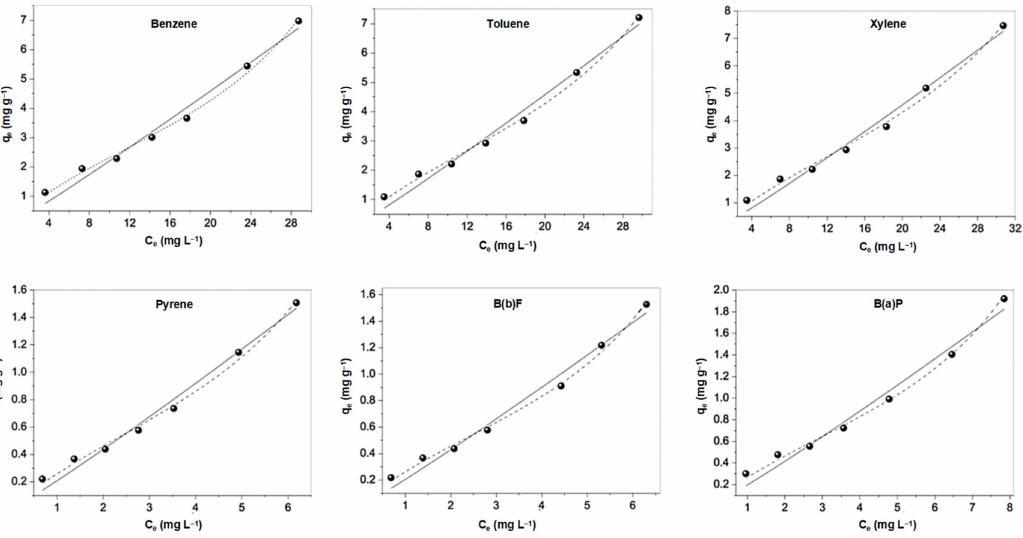
Figure 10. Adsorption isotherms of different aromatic hydrocarbon compounds at 25 ◦ C [58] (The solid line is the fit of the Freundlich model, and the dashed line is the fit of the BET